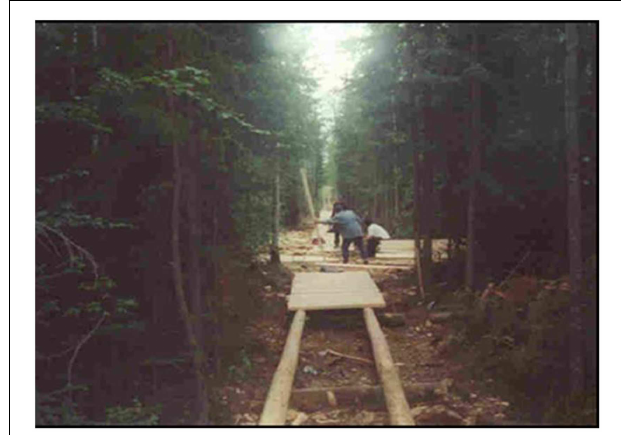
FIGURE 2 | Image showing a boardwalk portion of the walking trail under construction.